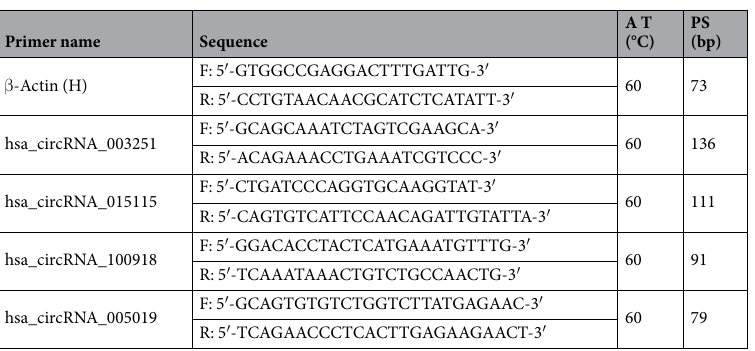
Table 2. Specific circRNA primers for quantitative PCR analysis. AT, annealing temperature; PS, product